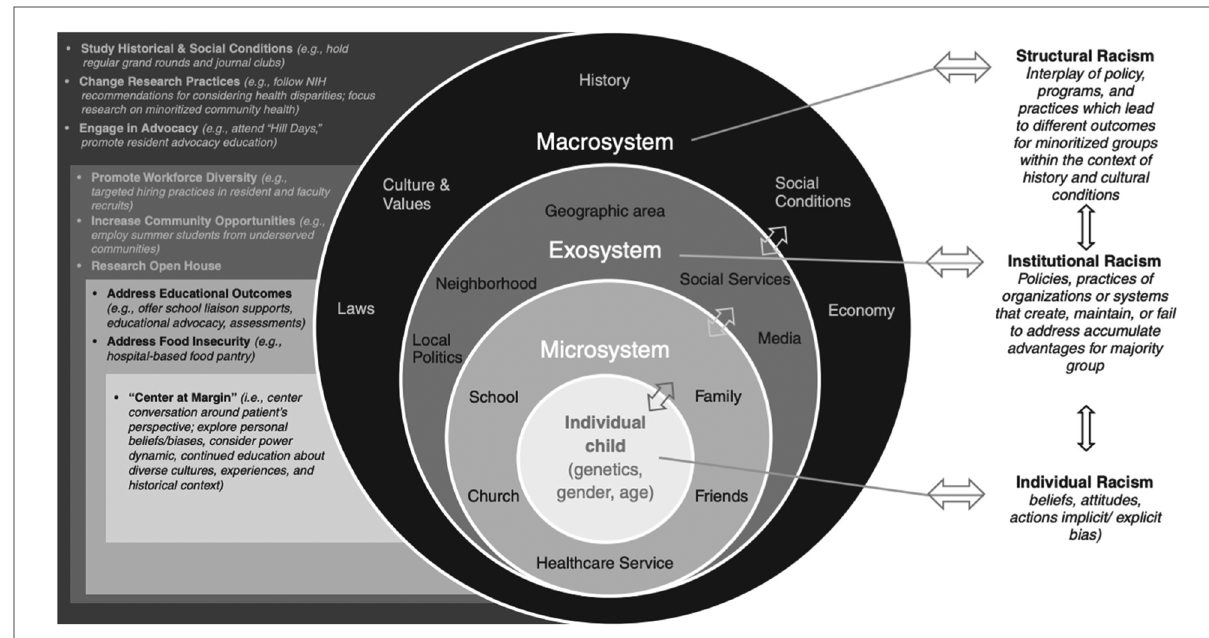
FIGURE 1 Illustration describing bronfenbrenner ’ s socioecologic model of child development, which is affected by racism at every level, therefore requiring parallel interventions to combat racial disparities in health outcomes for children with kidney disease (72). Originally published by Dawson et al., 2022. Used with